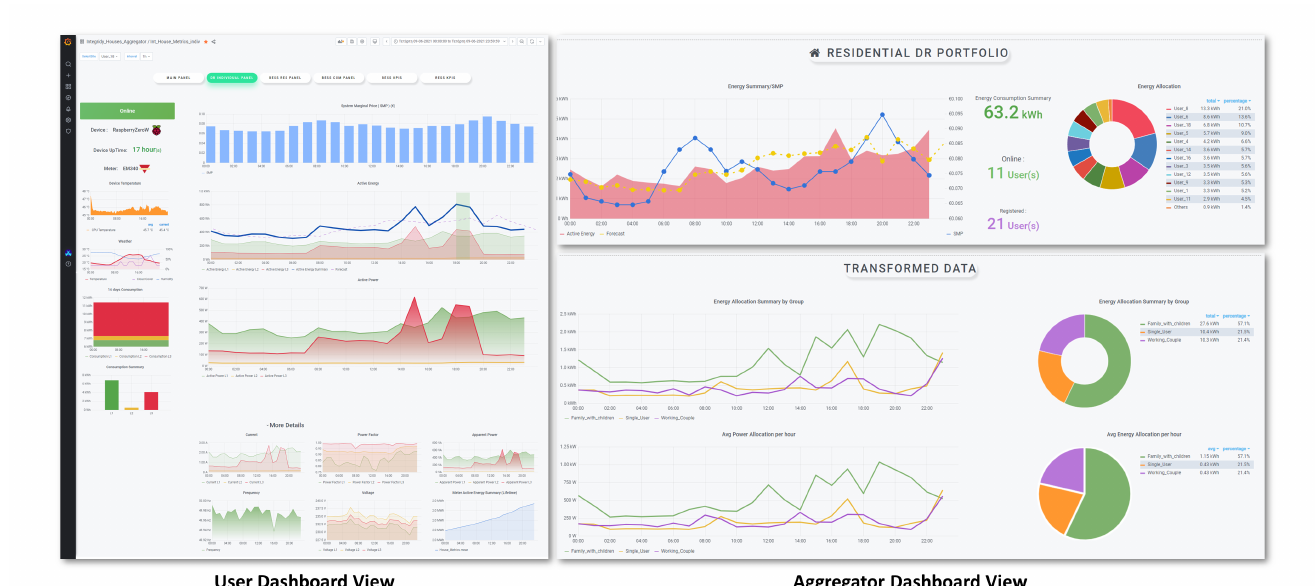
Figure 5. ODRes web-based